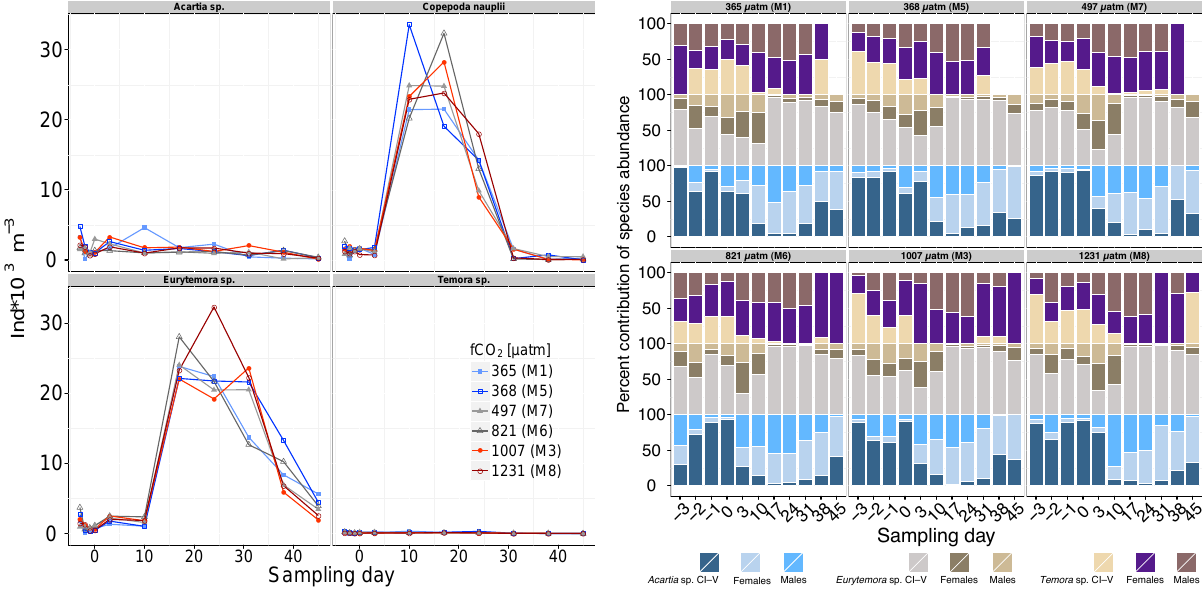
Figure 7. Left: abundance of the dominant copepod species Acartia sp., Eurytemora sp., Temora sp., and copepod nauplii. Right: percent contribution of different stages of dominant copepods.